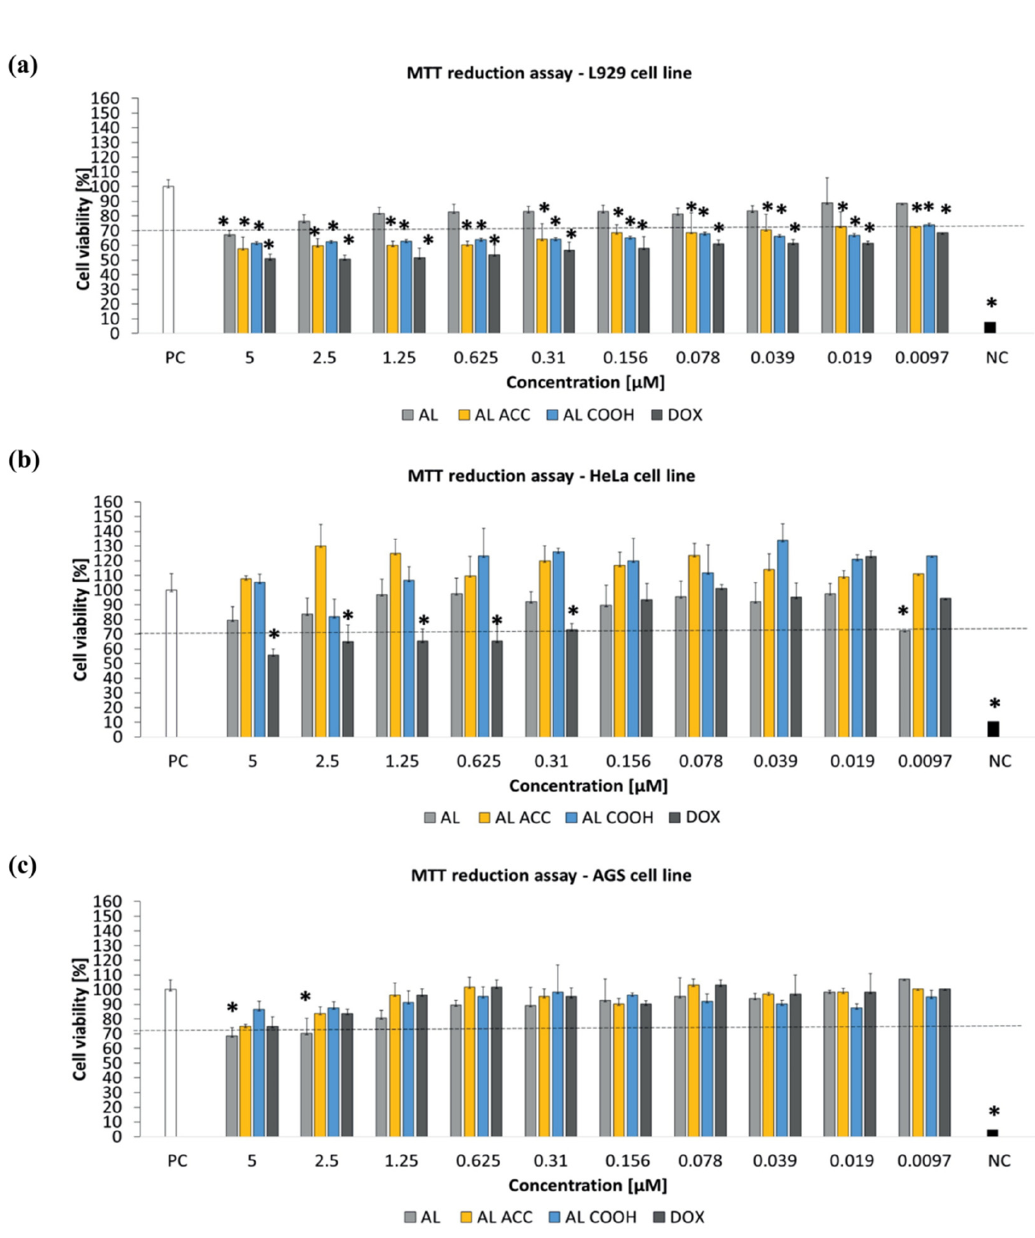
Figure 3. The cytotoxicity of blank NPs tested on ( a ) L929, ( b ) HeLa, and ( c ) AGS cell lines. Statistical significance: * p < 0.05; * untreated cells vs. cells treated with tested compounds as studied by Kost et al. Reprinted with permission from [58]; published by Elsevier, 2021.